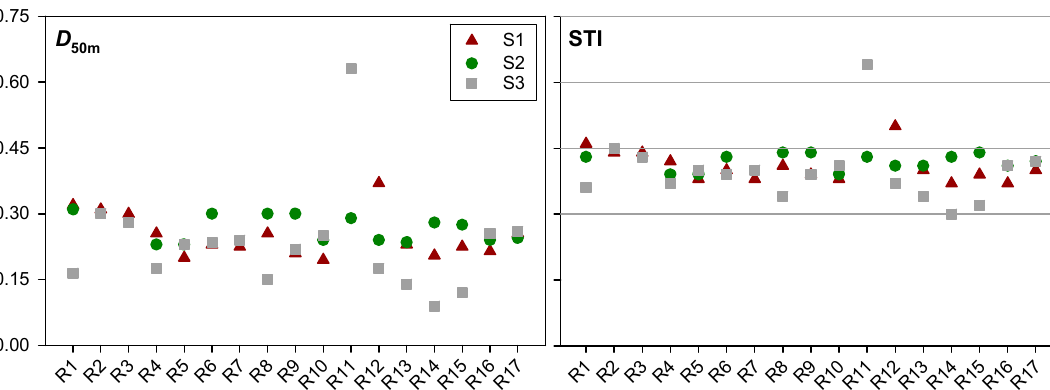
Figure 13. D 50m and STI results derived from the simulated RIR simulation at each source-receiver combination. York Minster’s Chapter House in its current state.